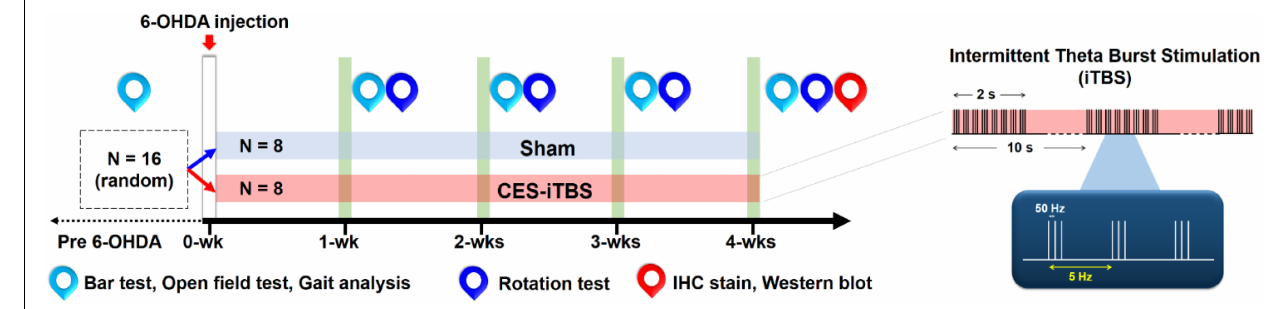
FIGURE 2 | Experimental design for the long-term CES treatment. CES treatment was performed 7 days a week for 4 successive weeks. Behavioral tests, including bar test, open-field test, gait analysis, and apomorphine-induced rotation behavior, were performed weekly to investigate the treatment effects over time. Immunohistochemistry (IHC) and western blot analyses were applied on the week-4 post PD lesion to identify the neuroprotective effects of dopaminergic neurons and fibers following 4 weeks of CES